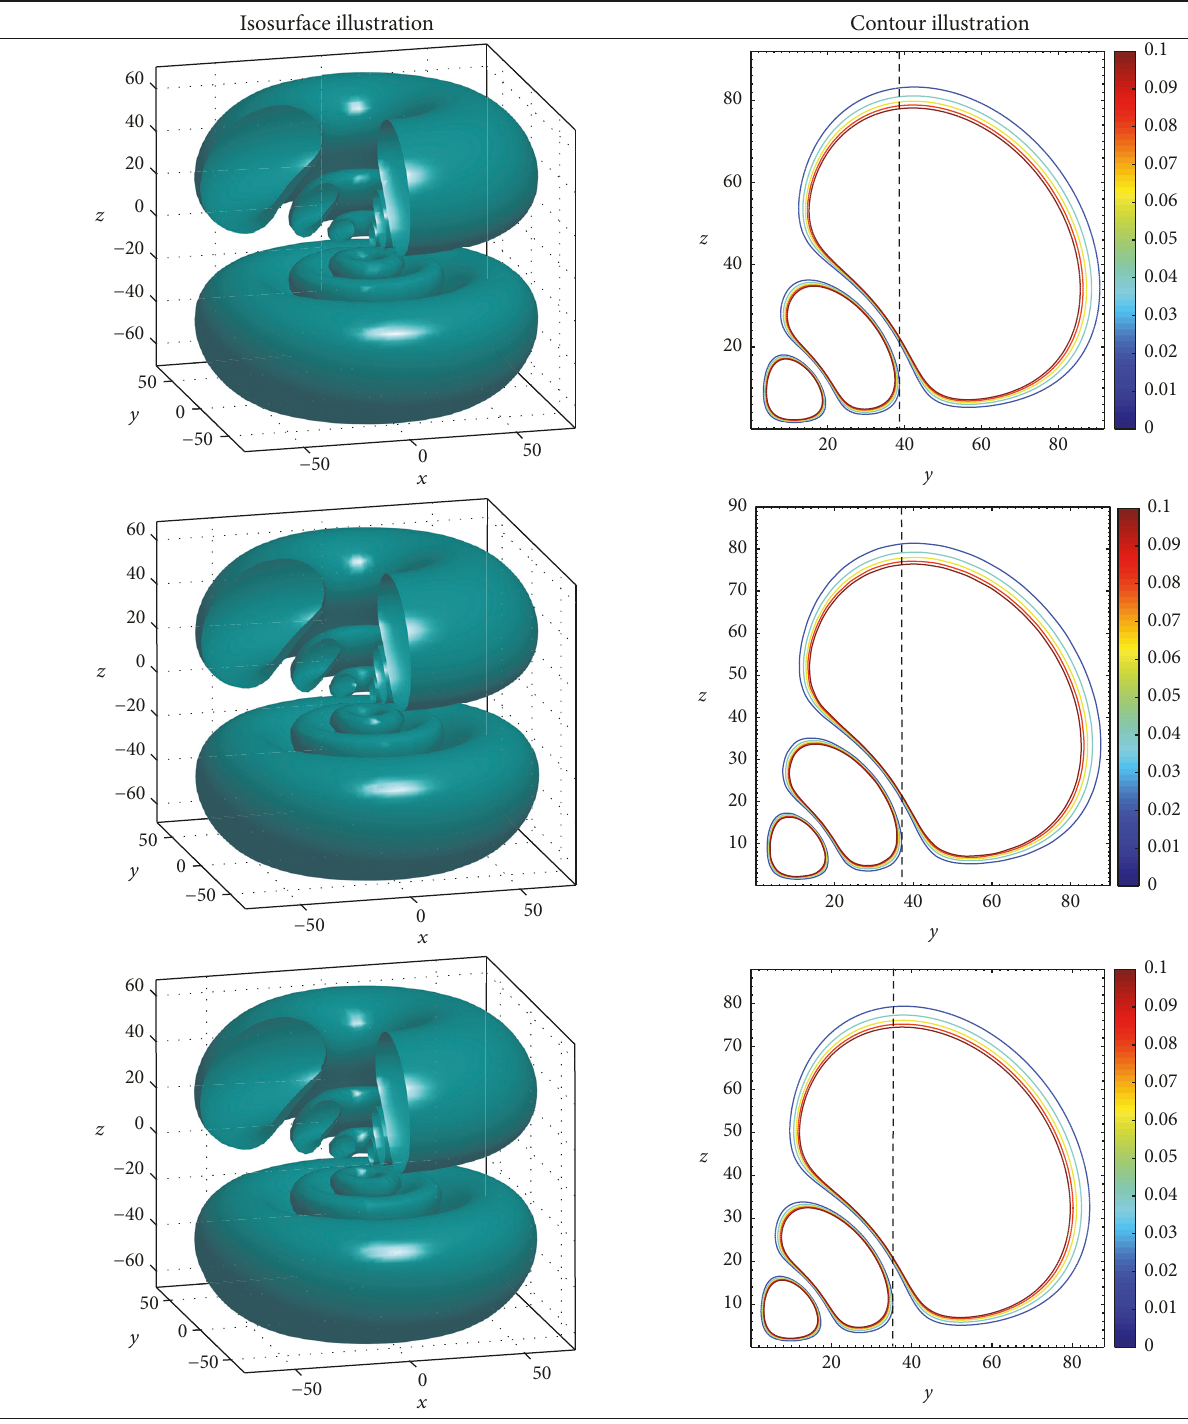
Table 5: SPDs for different cases of the value of 𝑏 for (4, 1, 0) when 𝑐 = 0.5 .